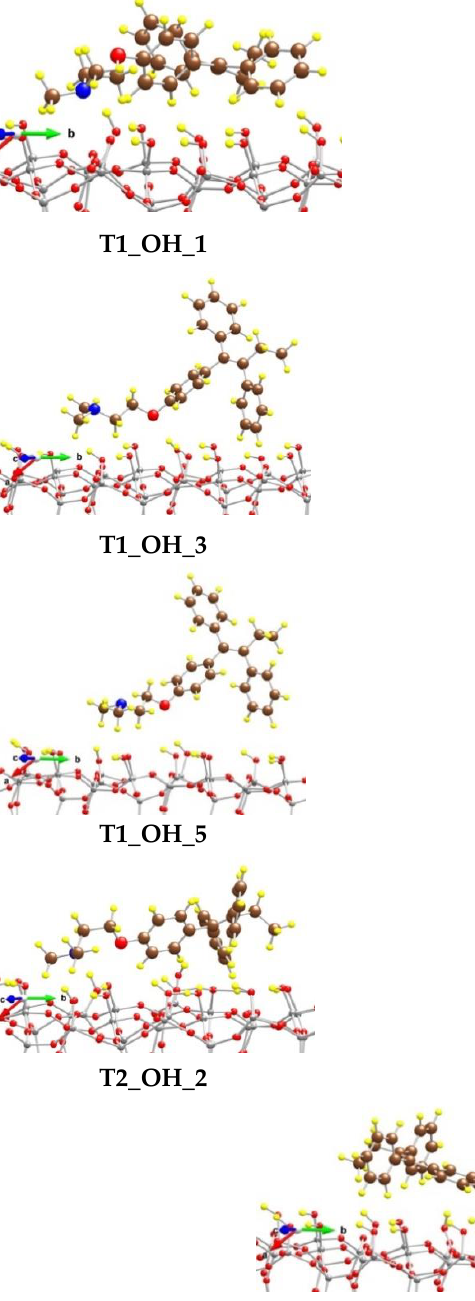
Figure 5. Optimized complexes of a tamoxifen molecule adsorbed on (SiOH)-terminated silicate surface. Color coding: Si—gray, C—brown, O—red, N—blue, and H—yellow. For visual clarity the O center from tamoxifen is represented with a larger sphere.